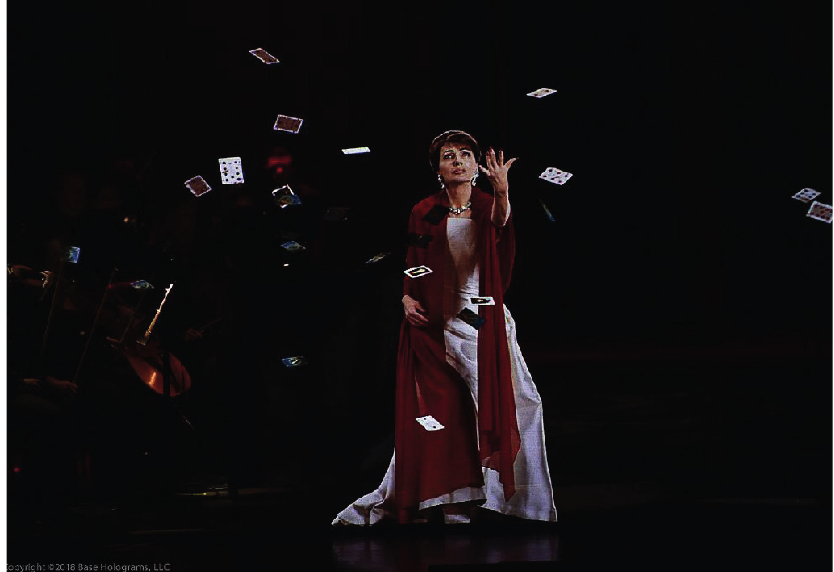
Fig. 5: The playing cards scene in Callas in Concert . (© Evan Agostini/Base